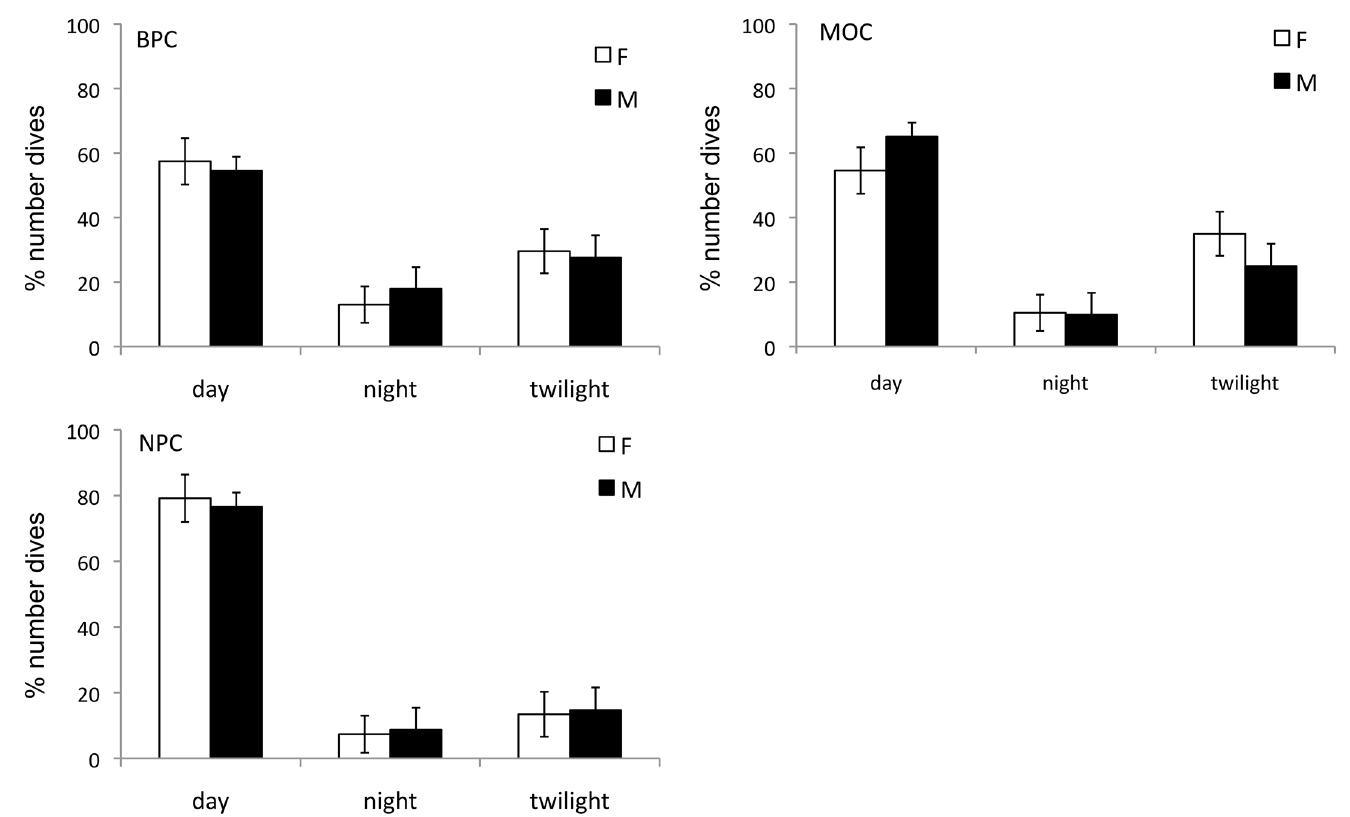
Fig 3. Mean percent daily number of dives by female and male murres according to light phase during BPC (top left), MOC (top right) and NPC (bottom left). Values are mean ± SE percent total number of dives day -1 across individuals ( χ 2 tests: p < 0005). Sample sizes provided in S1